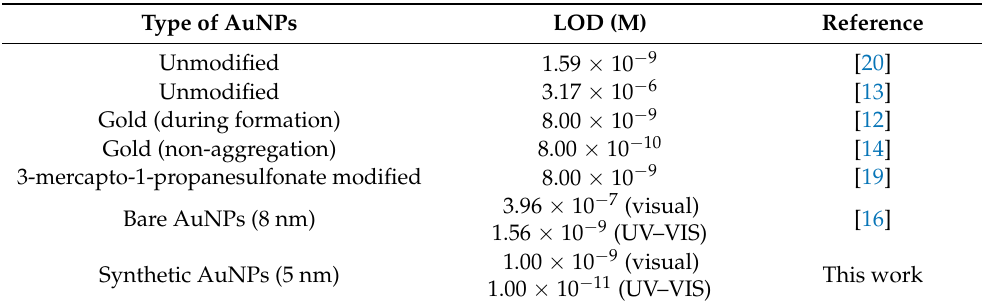
Table 1. Comparison of detection limits obtained in the present study with some established methods using AuNPs as a probe.